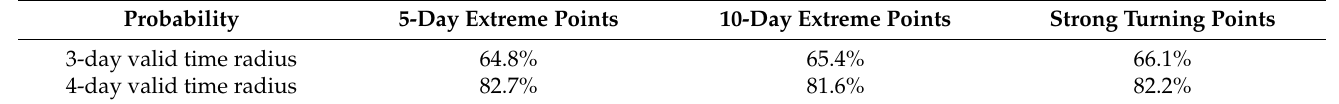
Table 6. Proportion of valid 5-day extreme points of the Shenzhen